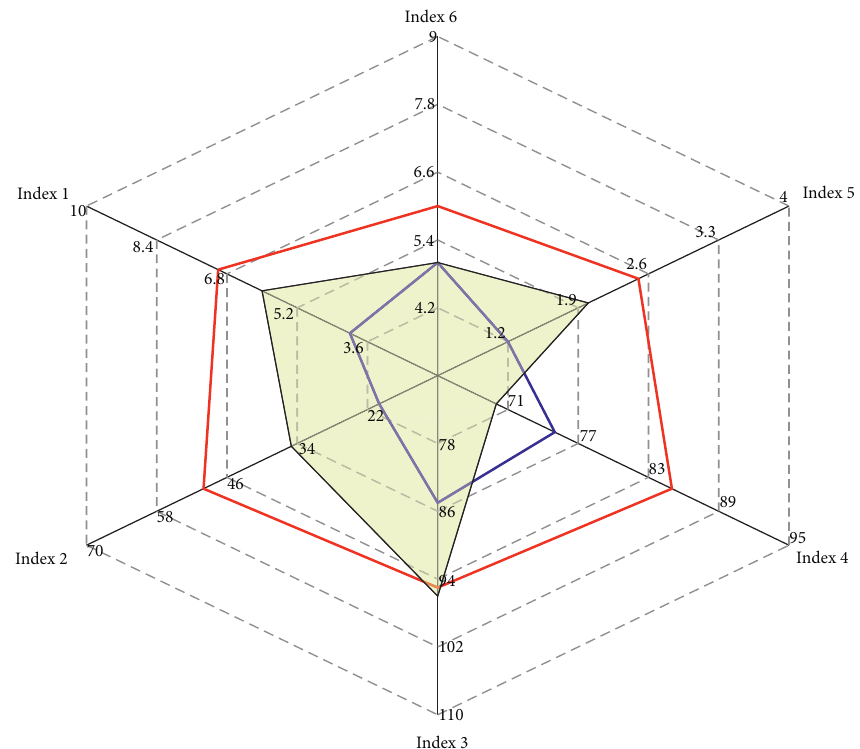
Figure 5: Distribution of employment early warning big data forecasting